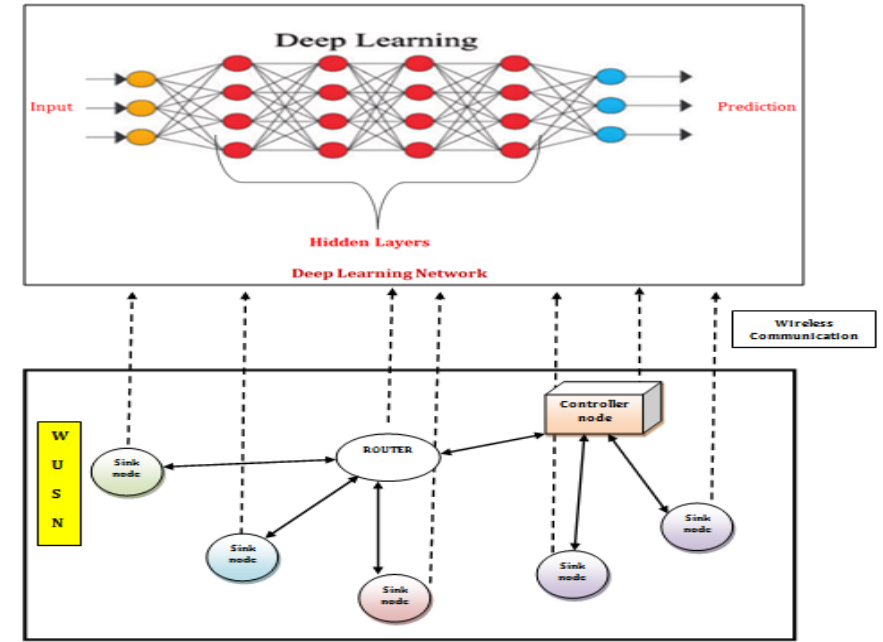
Figure 1. Deep learning network structure in WUSNs middleware.